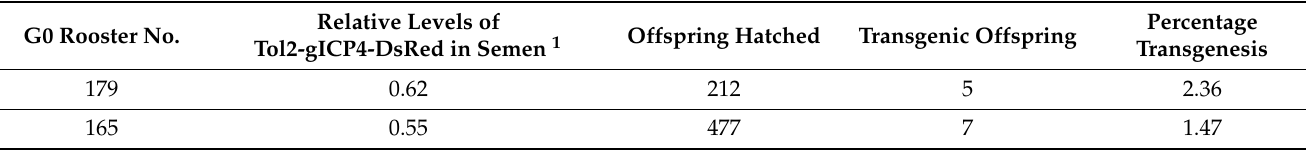
Figure 3. Generation of transgenic chickens and characterization of Cas9/gICP4 CEF. ( a ) Representative images of gonads harvested at stage 40 Hamburger Hamilton (HH) of injected embryos with the Tol2-gICP4-DsRed and pTrans complexed with L2000CD complex. DsRed (right) and corresponding bright field (left) images of representative gonads. Fluorescent image of a hatched G1 gICP4-DsRed ( b ) and the Cas9-GFP ( c ) hen used to expand the Cas9-GFP line for this study. Hatched chicks were visually screened for GFP and DsRed expression using specific light sources for GFP or DsRed equipped in the goggles (BLS LTD, Hungary) and images were captured with a camera. ( d ) CEF were prepared from 10-day-old embryos obtained by breeding gICP4-DsRed and Cas9-GFP chickens. PCR genotyping of individual CEF cultures was performed using specific primers targeting the Cas9 transgene (top panel), gICP4 transgene (middle panel) or endogenous ovomucoid (OVM) gene (lower panel). Lane 1, gICP4 alone; lanes 2, 3, 8 and 12, Cas9/gICP4; lanes 4, 5, 6, 7, 9, 10, 11 and 13, WT; lane 14, water control. ( e ) Fluorescent microscopy images of CEF cultures #1, #2 and #4 expressing DsRed alone (gICP4 transgene alone), GFP+DsRed (Cas9/gICP4 transgenes) or no fluorescence (WT), respectively. Table 2. Germline transmission and transgenic gICP4-DsRed chicken